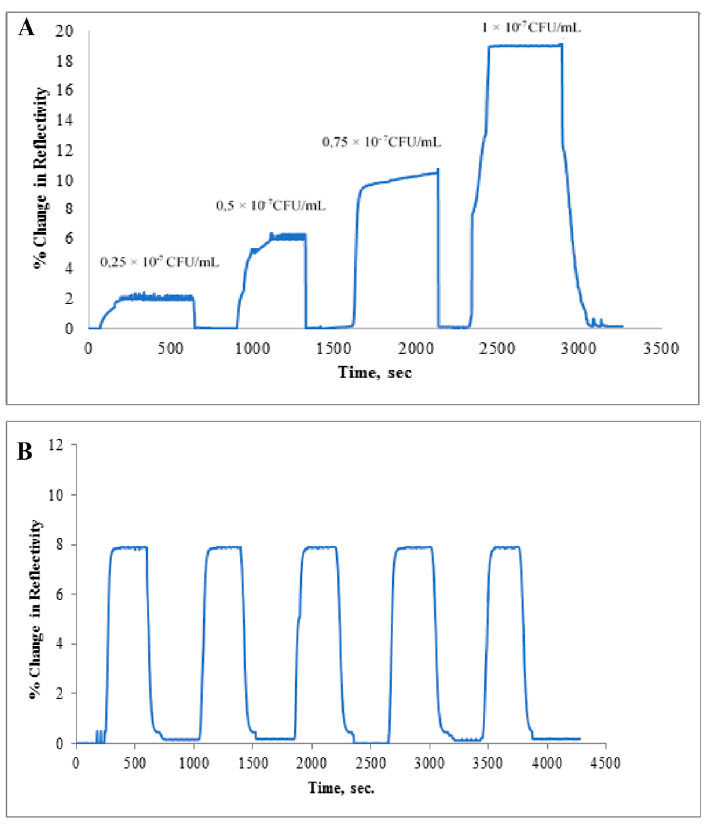
Figure 6. ( A ) Real-time responses of microcontact- S. paratyphi imprinted SPR chips against apple juice spiked with S. paratyphi at different concentrations in the range of 2.5 × 10 6 –10 × 10 6 CFU/mL, ( B ) Reusability of microcontact- S. paratyphi imprinted SPR chips at the concentration of 7.5 × 10 6 CFU/mL.